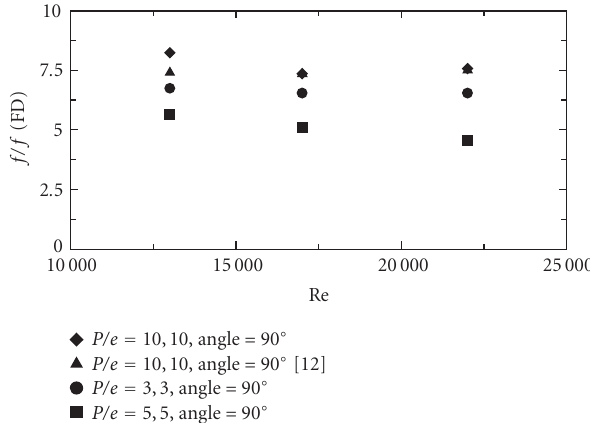
Figure 3: Variation of the friction factor ratio in a stationary 90 ◦ ribbed